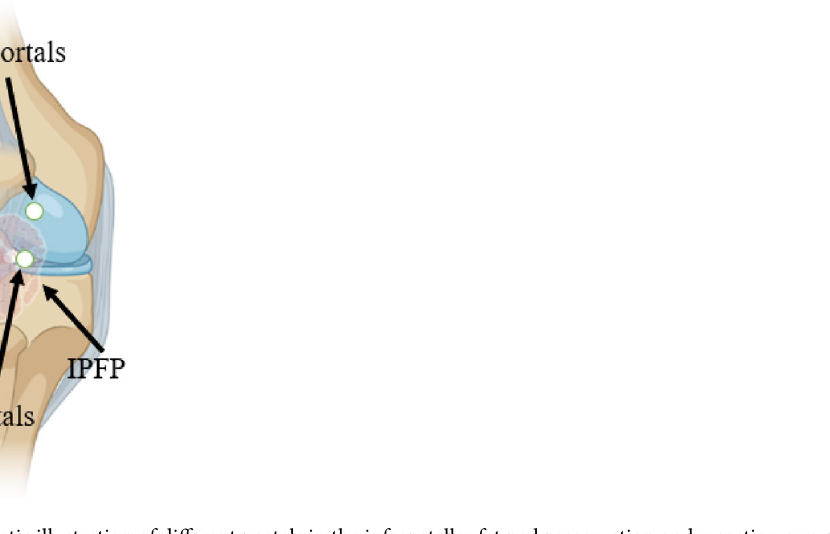
Figure 2. Schematic illustration of different portals in the infrapatellar fat pad preservation and resection group ( IPFP infrapatellar fat